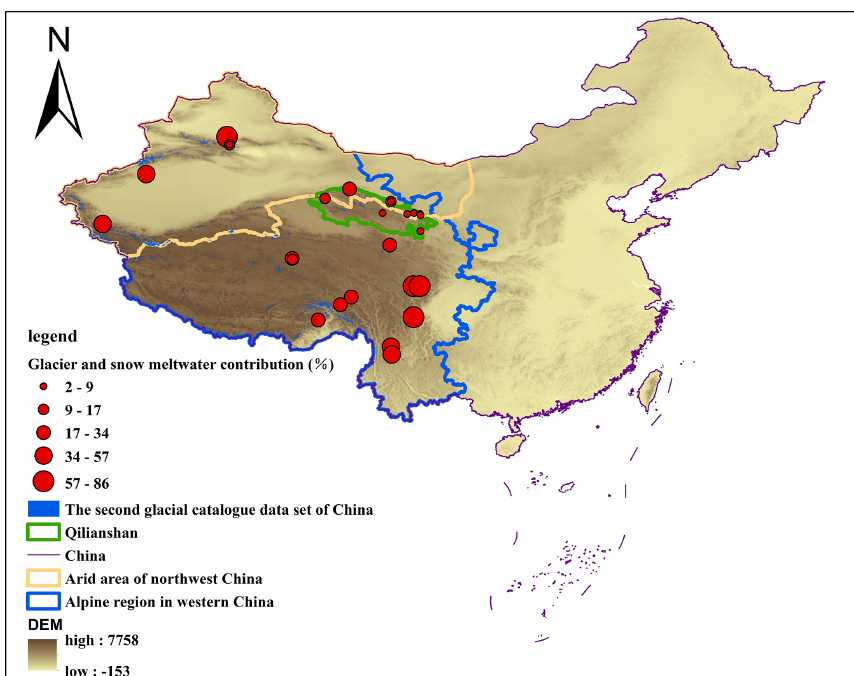
Figure 13. Contribution of glacier and snow meltwater to runoff in alpine regions of